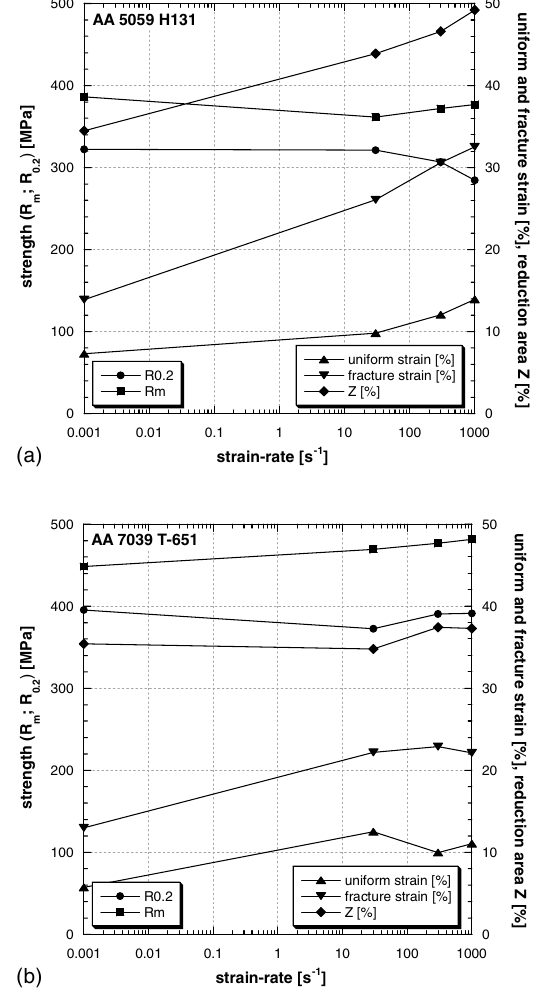
Fig. 10. (a) Trend of principal mechanical characteristics in function of the strain-rate for AA 5059-H131. (b) Trend of principal mechanical characteristics in function of the strain-rate for 7039-T651.